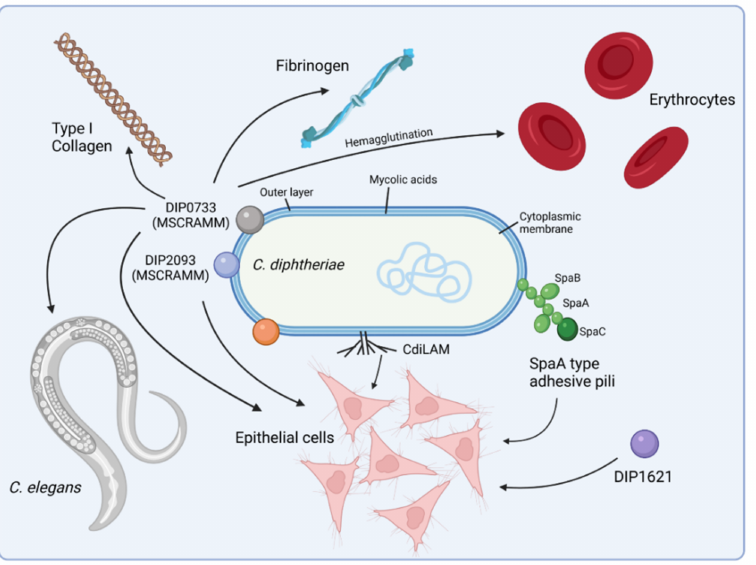
Figure 2. Adhesion of C. diphtheriae : a multi-factorial process. C. diphtheriae can bind different epithelial cell types in a strain-specific manner. Several proteins involved in this process have been identified thus far, including adhesive pili and MSCRAMMS (Microbial Surface Components Recognizing Adhesive Matrix Molecules), which mediate attachment to fibrinogen or collagen. Deletion or disruption of single genes encoding one of these proteins results typically in only a minor loss of adhesion, indicating that a combination of independent adhesion mechanisms act together. In addition, C. diphtheriae can bind to human erythrocytes, which may support spreading of the bacteria via the bloodstream within the whole body [31] (figure created with